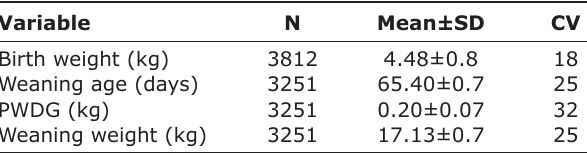
Table-1: Descriptive statistics for birth weight, weaning weight, weaning age, and pre-weaning daily gain in Awassi